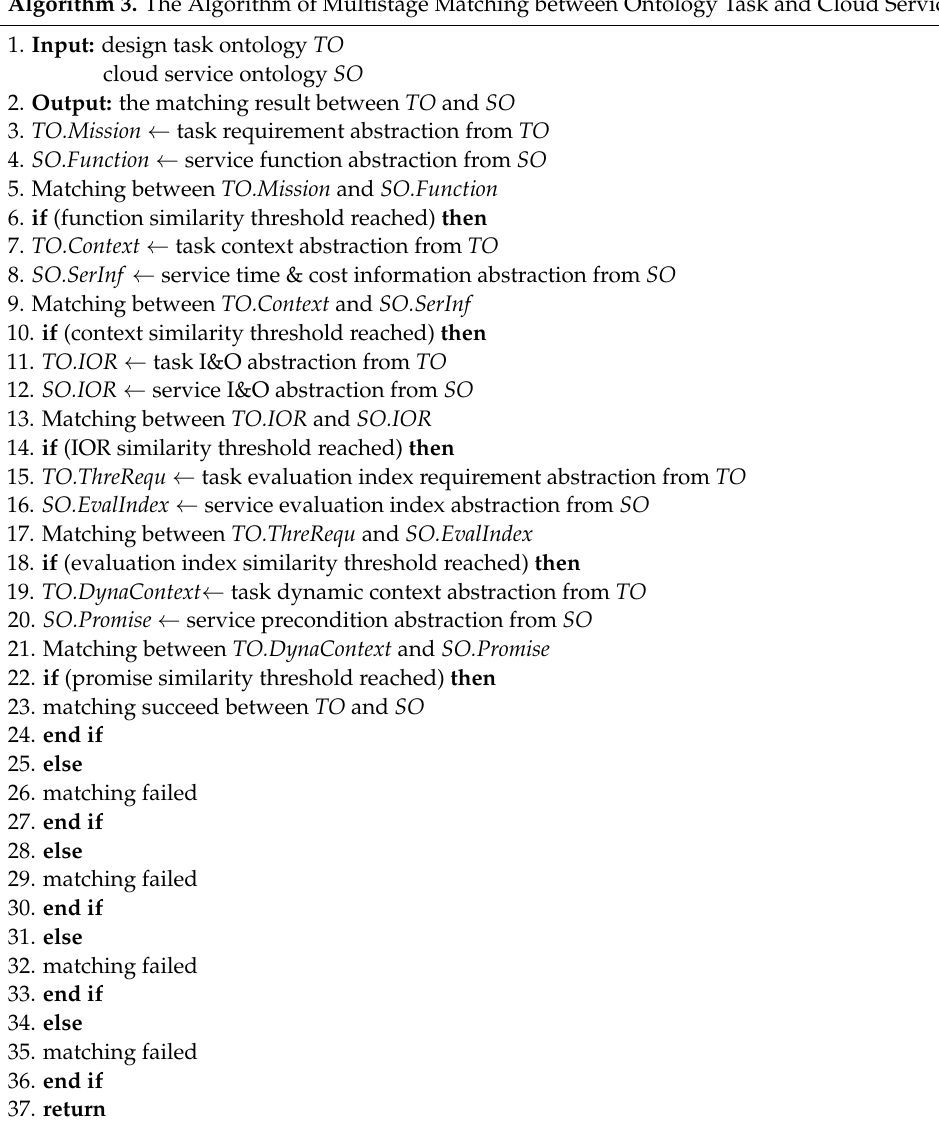
Algorithm 3. The Algorithm of Multistage Matching between Ontology Task and Cloud